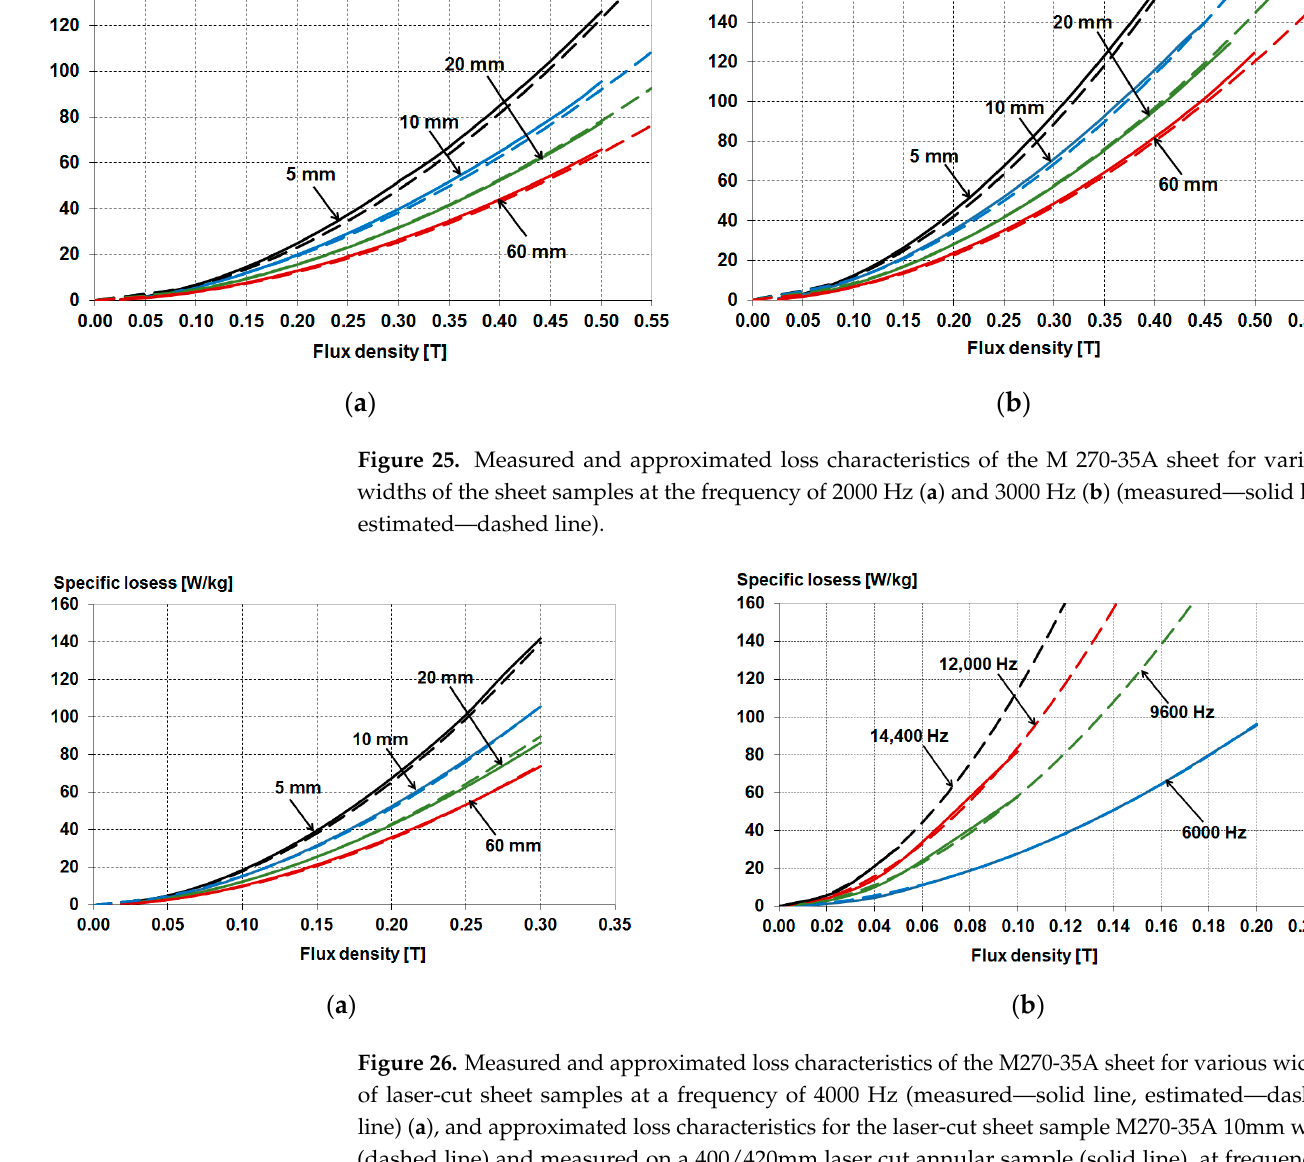
Figure 26. Measured and approximated loss characteristics of the M270-35A sheet for various widths of laser-cut sheet samples at a frequency of 4000 Hz (measured—solid line, estimated— dashed line) ( a ), and approximated loss characteristics for the laser-cut sheet sample M270-35A 10mm wide (dashed line) and measured on a 400/420mm laser cut annular sample (solid line), at frequencies 4000 Hz < f ≤ 14,400 Hz ( b ).